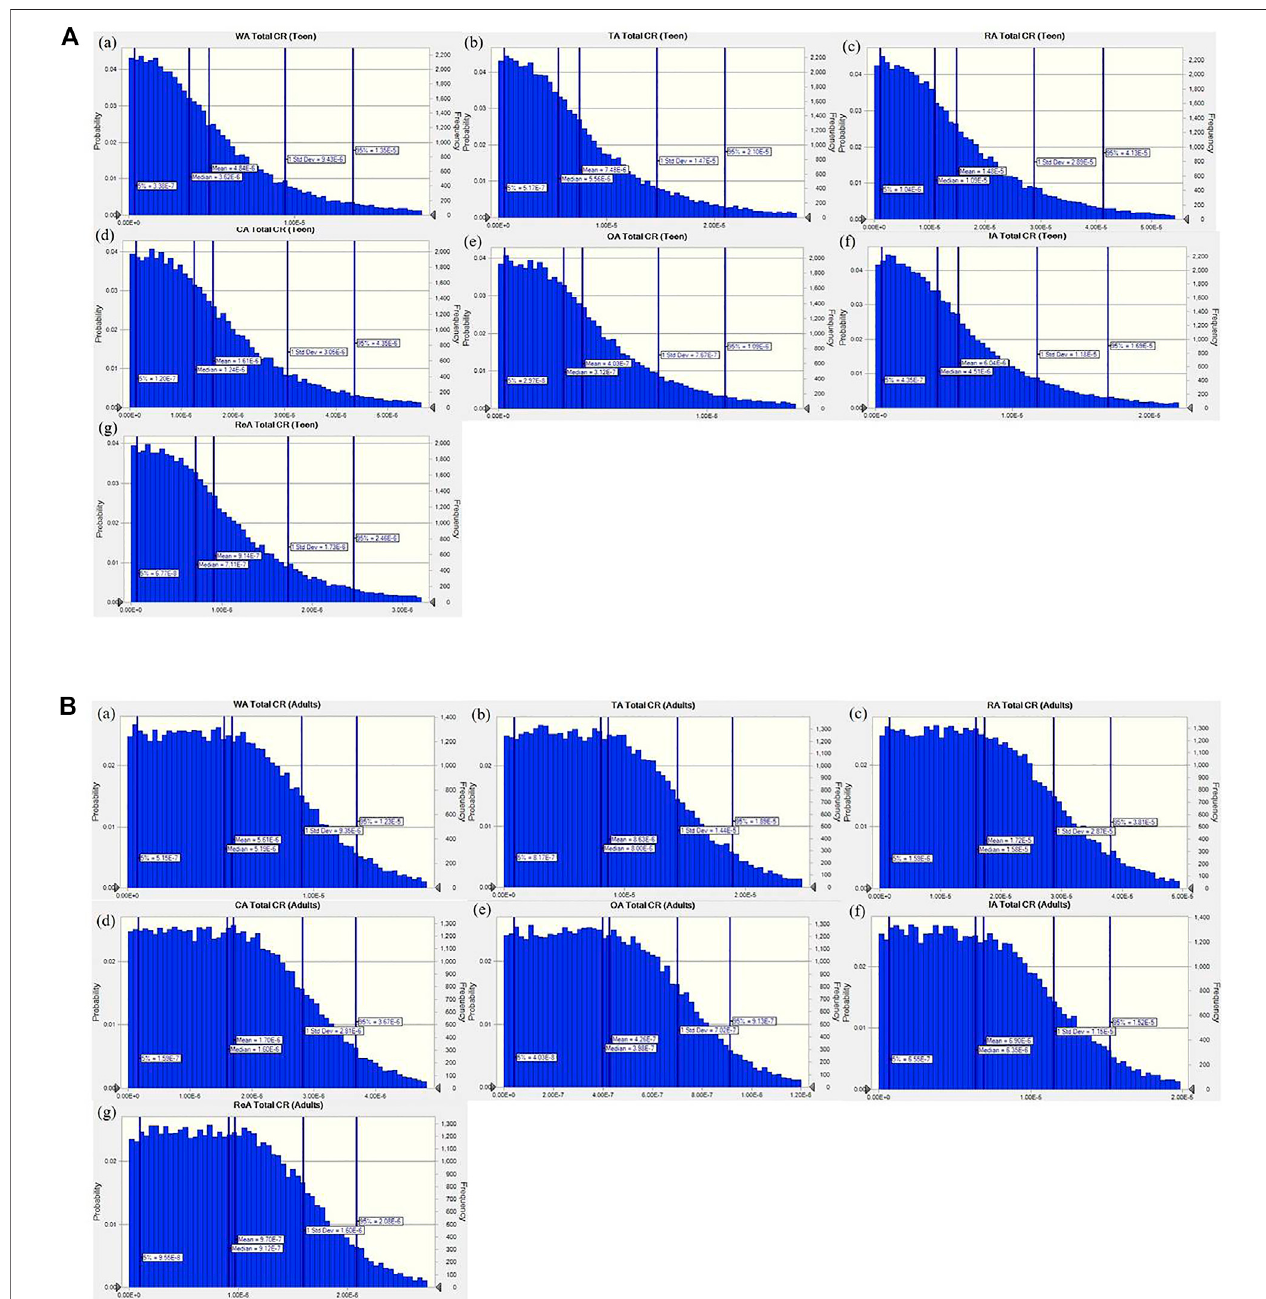
FIGURE1|(A) ProbabilitydensityfunctionsfromMonteCarlosimulationsusedtopredictCR(95%con fi dencelevel)fromsoil-boundPAHsfortheteengroupat(a) WA, (b) TA, (c) RA, (d) CA, (e) OA, (f) IA, and (g) ReA. (B) Probability density functions from Monte Carlo simulations used to predict CR (95% con fi dence level) from soil- bound PAHs for the adult group at (a) WA, (b) TA, (c) RA, (d) CA, (e) OA, (f) IA, and (g) ReA.